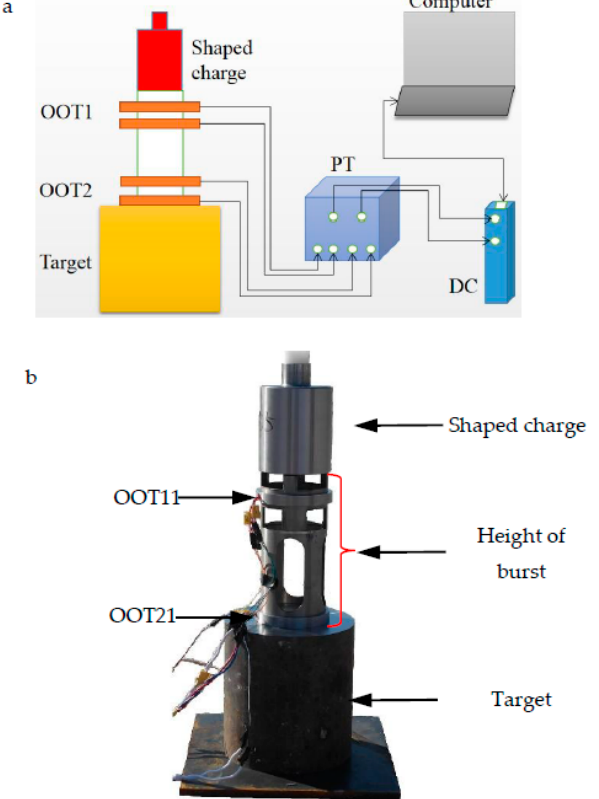
Figure 20. System composition diagram and experimental device: ( a ) speed measuring system; ( b ) test device.